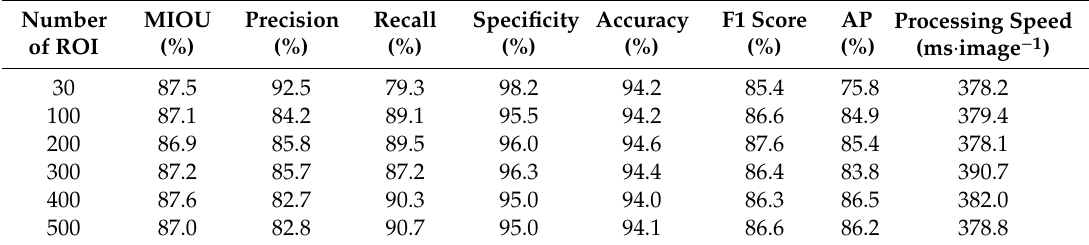
Table 6. Performance of the detectors trained with various numbers of regions of interest